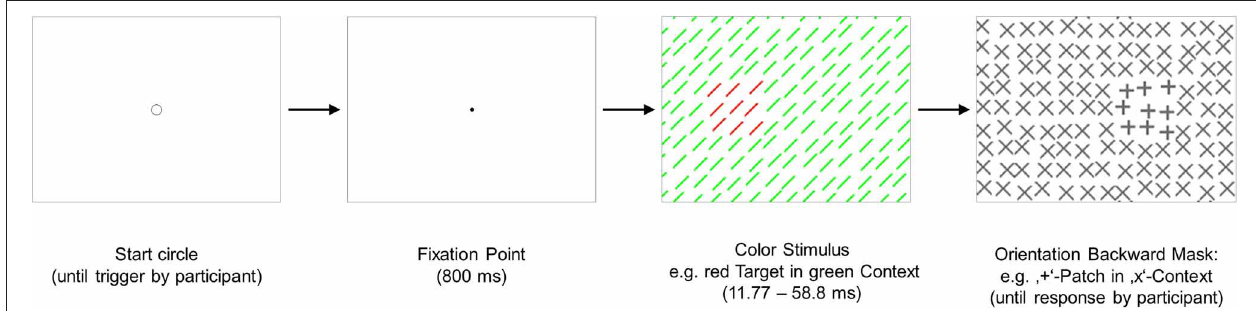
FIGURE 1 | Experiment 1: a graphical illustration of the sequence and timing of stimulus and backward mask on each trial. Stimulus texture: with color-defined target. Mask texture: with irrelevant